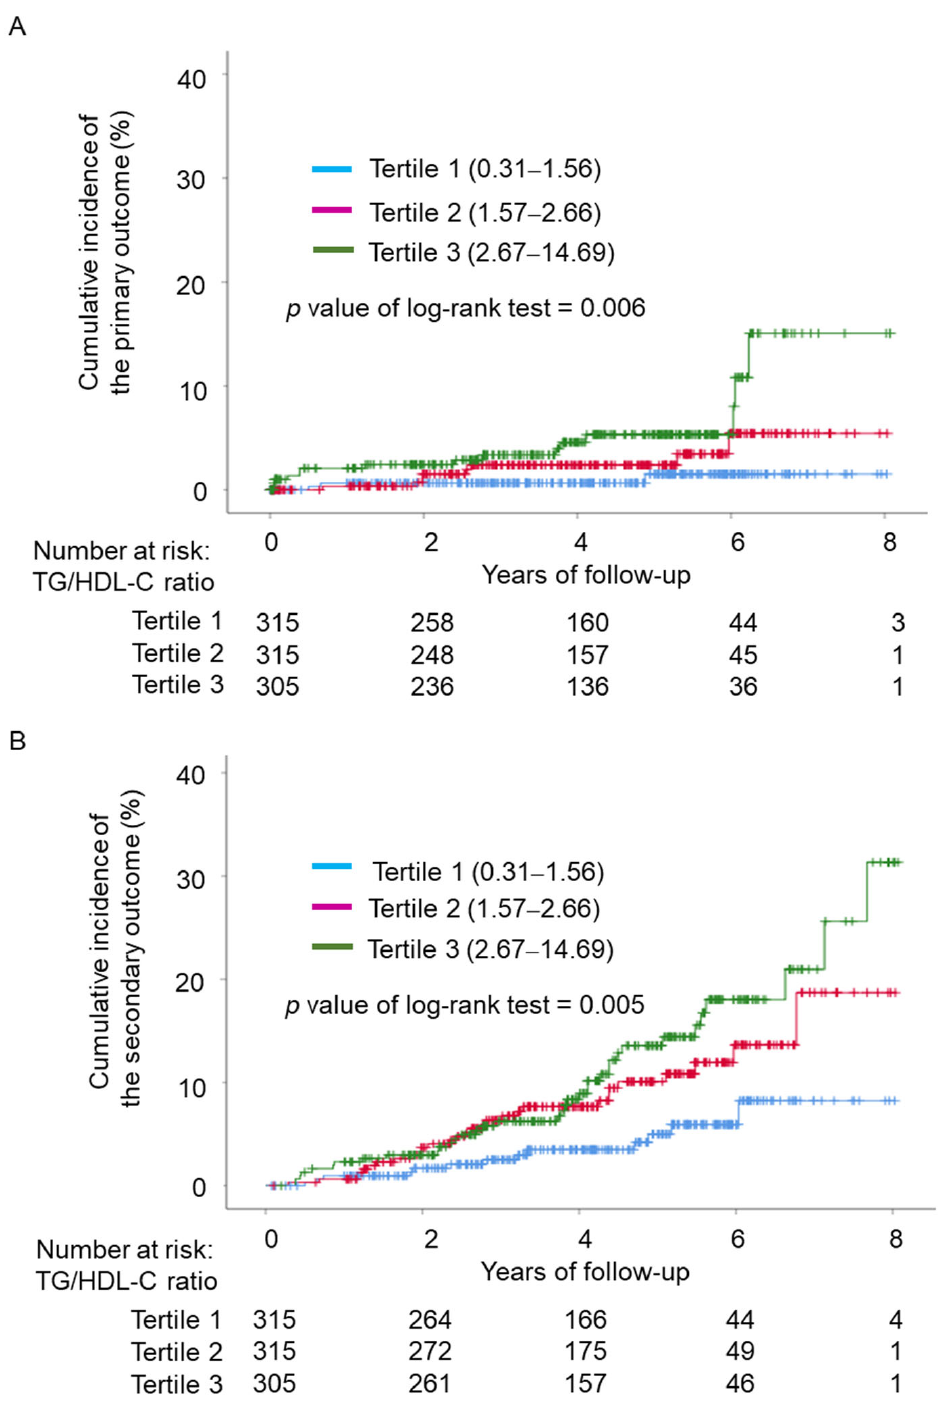
Figure 2. Kaplan–Meier plot of cumulative incidence of cardiovascular events by TG/HDL-C ratio tertiles. ( A ) Time to the primary outcome including cardiovascular death and acute coronary syndrome, according to the baseline TG/HDL-C ratio. ( B ) Time to the secondary outcome including cardiovascular death, acute coronary syndrome, or late coronary revascularization, according to the baseline TG/HDL-C ratio. TG, triglyceride; HDL-C, high-density lipoprotein cholesterol.